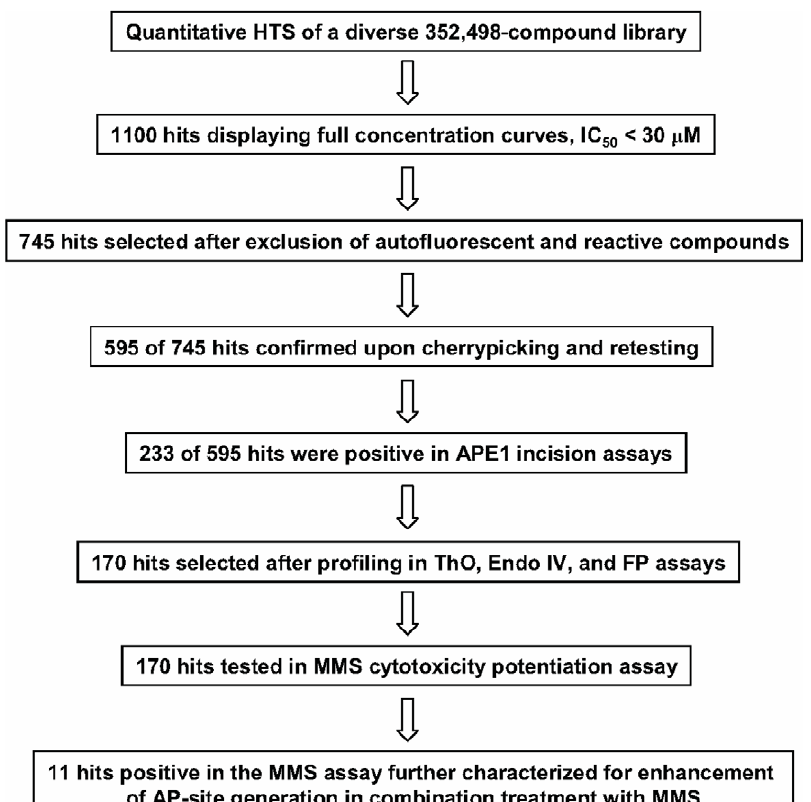
Figure 3. Hit progression flow chart.